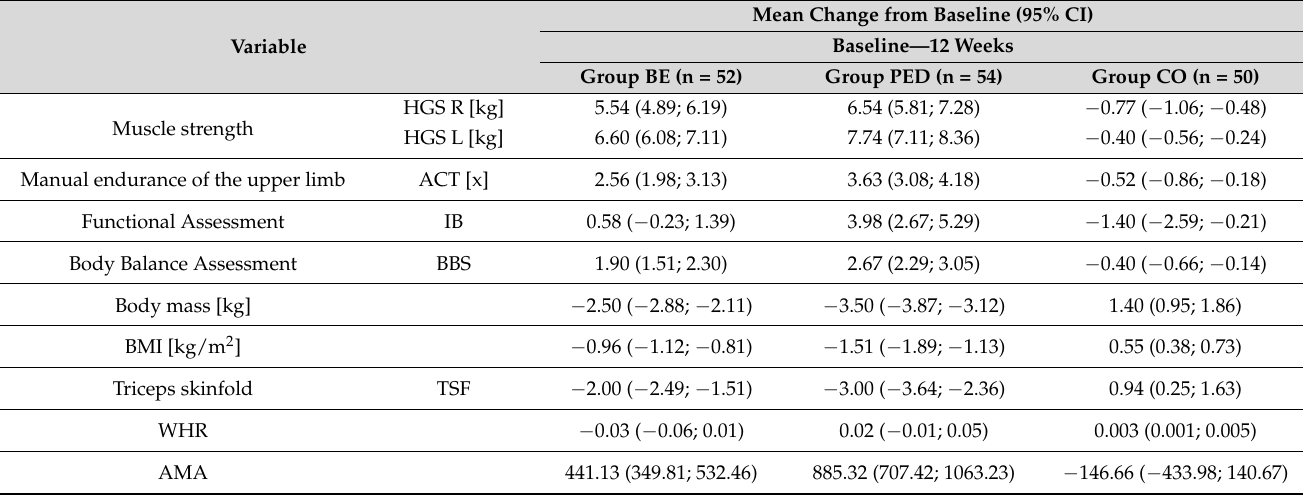
Table 3. Mean difference scores for each group across time.